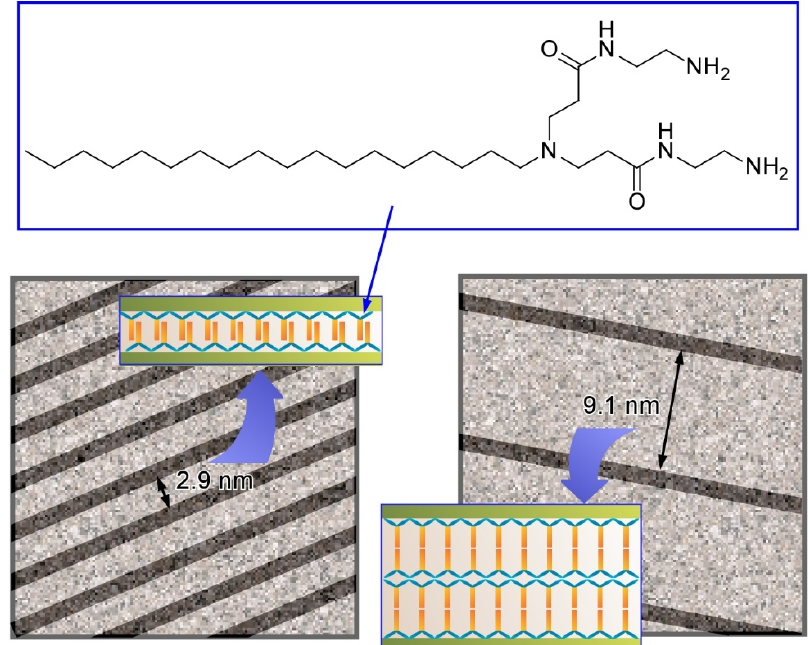
Figure 13. Parallel allays of the Au nanowires with regular wire-by-wire intervals (models) with narrow interval of 2.9 nm and wide interval of 9.1 nm, corresponding to interdigitated bilayer and non-interdigitated four layer of the ascorbic acid derivatives, respectively.